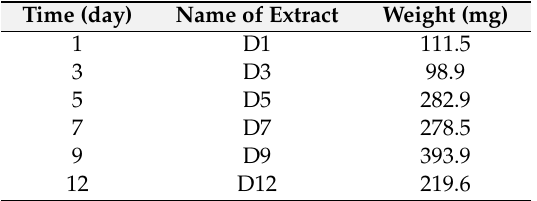
Table 1. Production of extracts of Botrytis cinerea at different growing times.